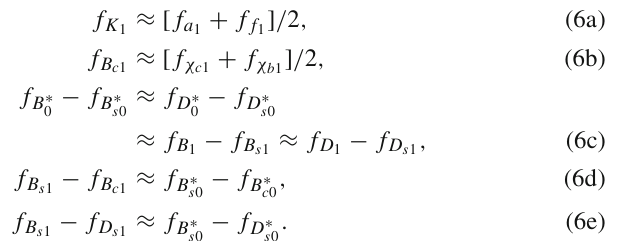
Fig. 1 Upper panel – a Comparison between CI predictions for meson masses and available experiment [1] and m B ∗ [21]. Lowerpanel – b CIpredictionsformesonleptonicdecayconstants comparedwithexperiment[1],whereknown,andlQCDotherwise[64–